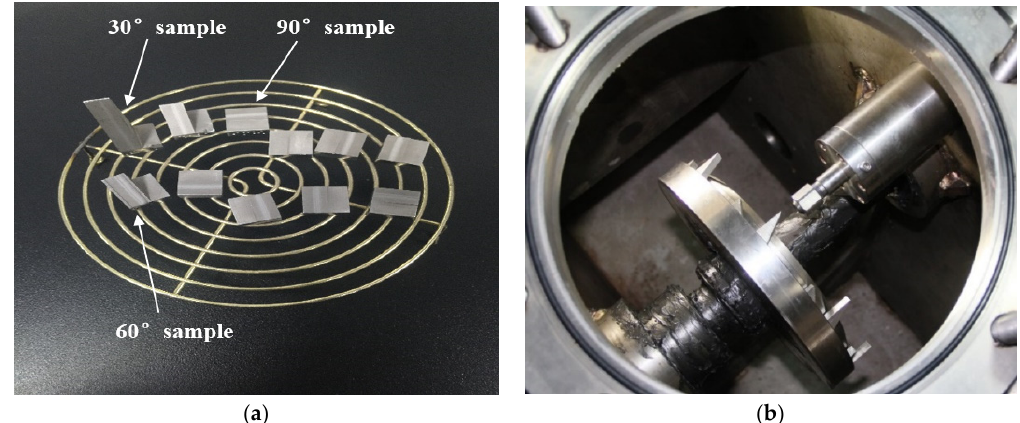
Figure 2. Sample structure and layout. ( a ) The sample structure; ( b ) The layout of samples in impeller disk.